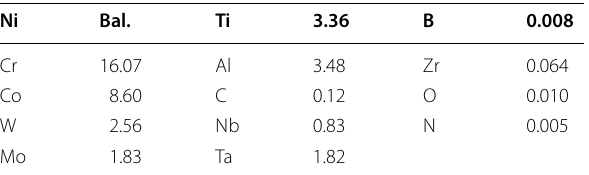
Table 1 Chemical compositions of Inconel 738LC powders